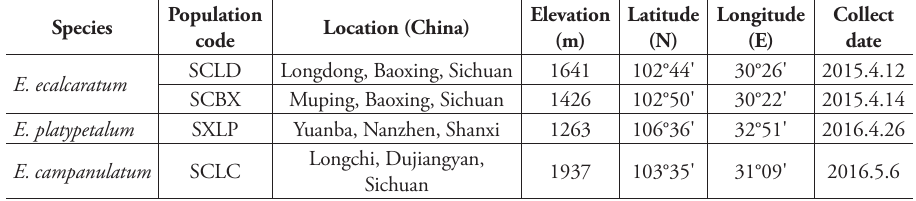
Table 1. Location and habitat characters of populations of E. ecalcaratum , E. platypetalum , and E. cam- panulatum